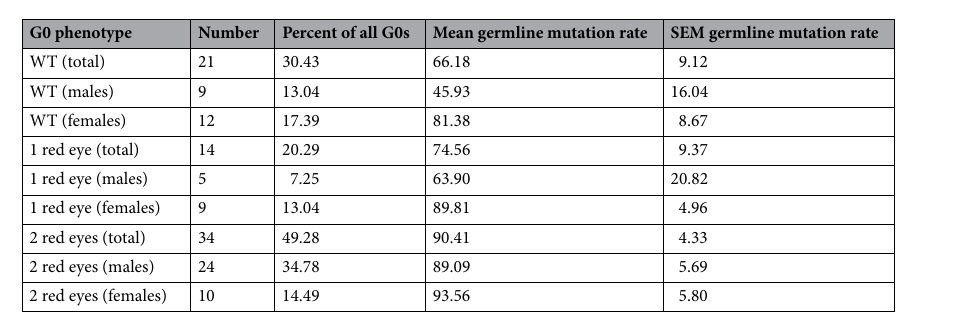
Figure 4. Phenotypes of homozygous Of-v lines across lifespan. Photographs of whole animals or heads of different individuals are shown in ( A–G ). ( A ) First instar nymphs, ( B ) second instar nymphs, ( C ) third instar nymphs, ( D ) fourth instar nymphs, ( E ) fifth instar nymphs, ( F ) adult females, ( G ) adult males. (i) Dorsal view of each genotype in the following order: v WT , v 1 , v 3 , v 4 . (ii) Lateral view of each genotype in the same order as shown in i. (iii–vi) Close-up view of right compound eye from individuals shown in i–ii, with genotypes indicated at top. Wild-type and v phenotypes are essentially indistinguishable during the first instar ( A ), but differences in coloration become apparent as wild-type eyes darken by the second instar ( B ), while v compound eyes remain red for the rest of nymphal development ( C–E ) and appear bright red in adults ( F,G ).